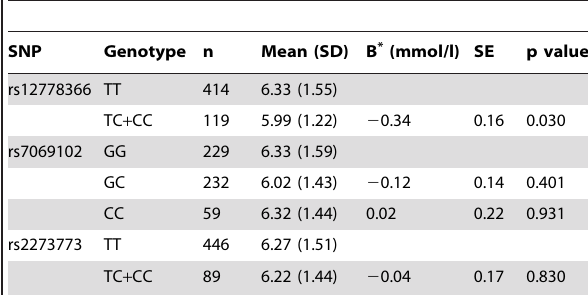
Table 4. Glucose levels (mmol/l) measured in males after the oral glucose tolerance test